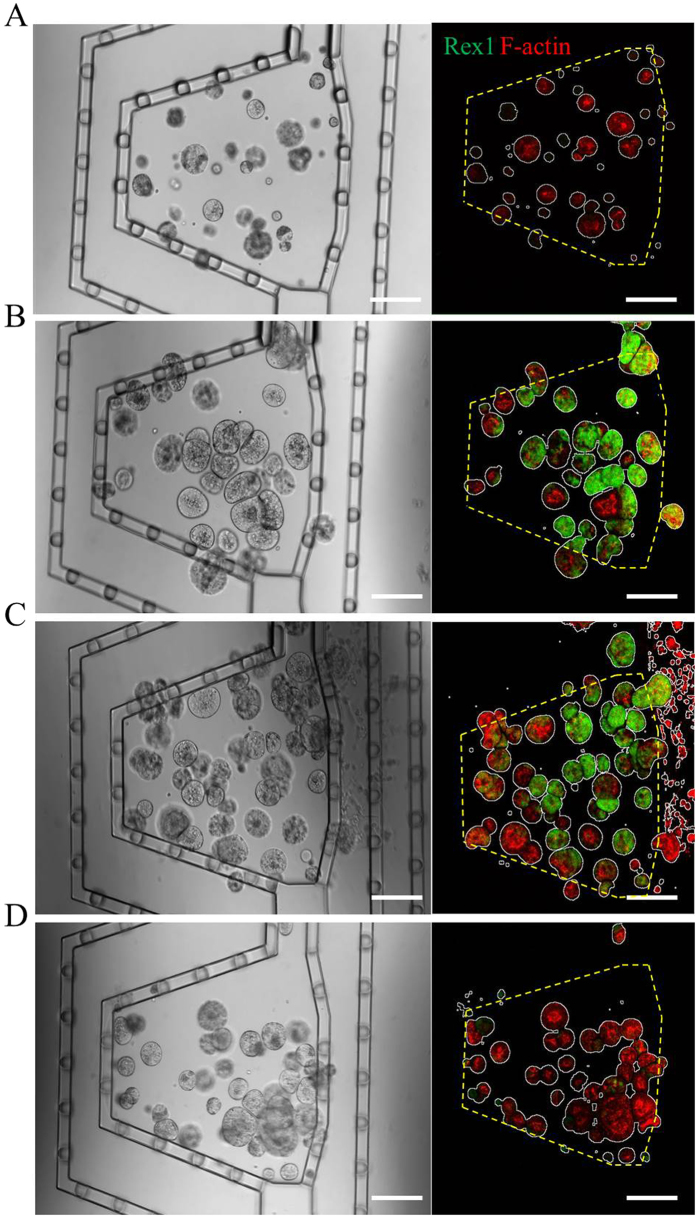
Exposure of mESCs to various LIF gradients.mESCs were cultured for 4 days in the device and their fate locally perturbed with three different formats of LIF-based stimulation. Cells were cultured (A) without or in presence of (B) the gradient of soluble LIF with source concentration of 20 ng/mL, (C) patterned SNLP cells that overexpress LIF with density of 1200 cells/μL, and (D) the gradient of immobilized LIF where the gel was treated with Fc-LIF for 8 hours. Gradual distribution of Rex1 (green) and F-actin polarization (red) can be observed in some conditions. White outlines indicate colonies stained with DAPI and yellow lines indicate borders of the hydrogel compartment. Scale bars indicate 200 μm.